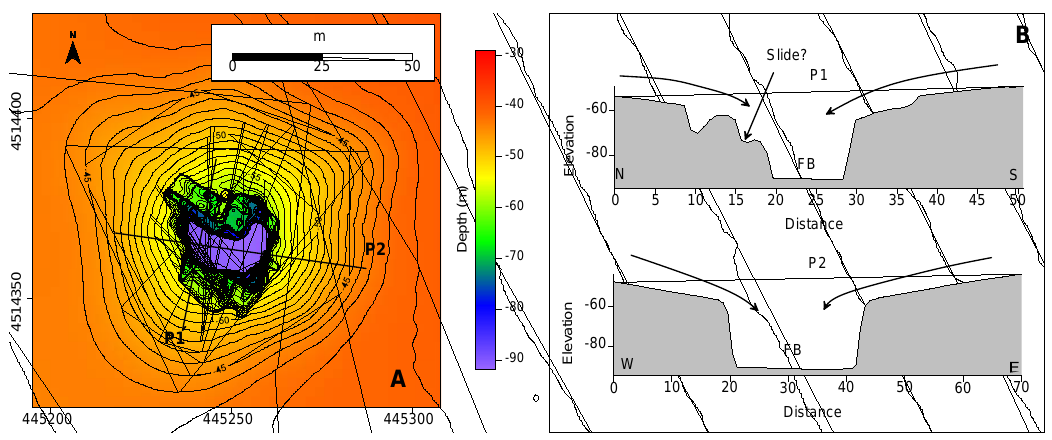
Figure 3. ( A ) High-resolution DTM of the Bocca dei Pescatori (BdP; grid cell at 1 m). ( B ) P1 and P2 elevation profiles extracted by the DTM (profile locations in A ).